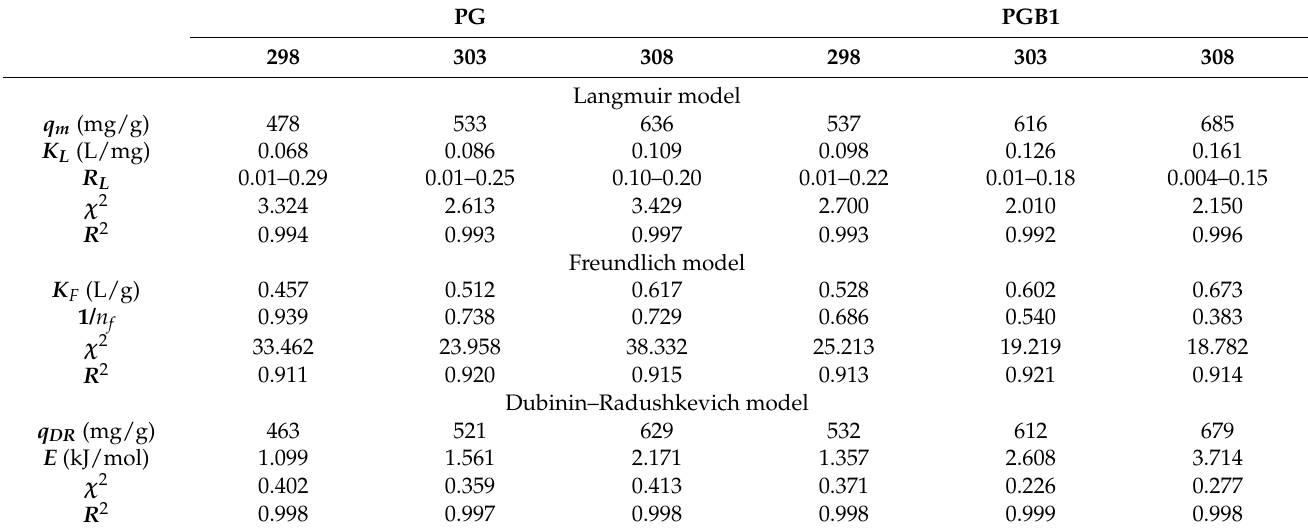
Table 3. Parameter values corresponding to Langmuir, Freundlich, and Dubinin–Radushkevich isotherms calculated in case of 1,2,4-triazole sorption on PG and PGB1 copolymers at different